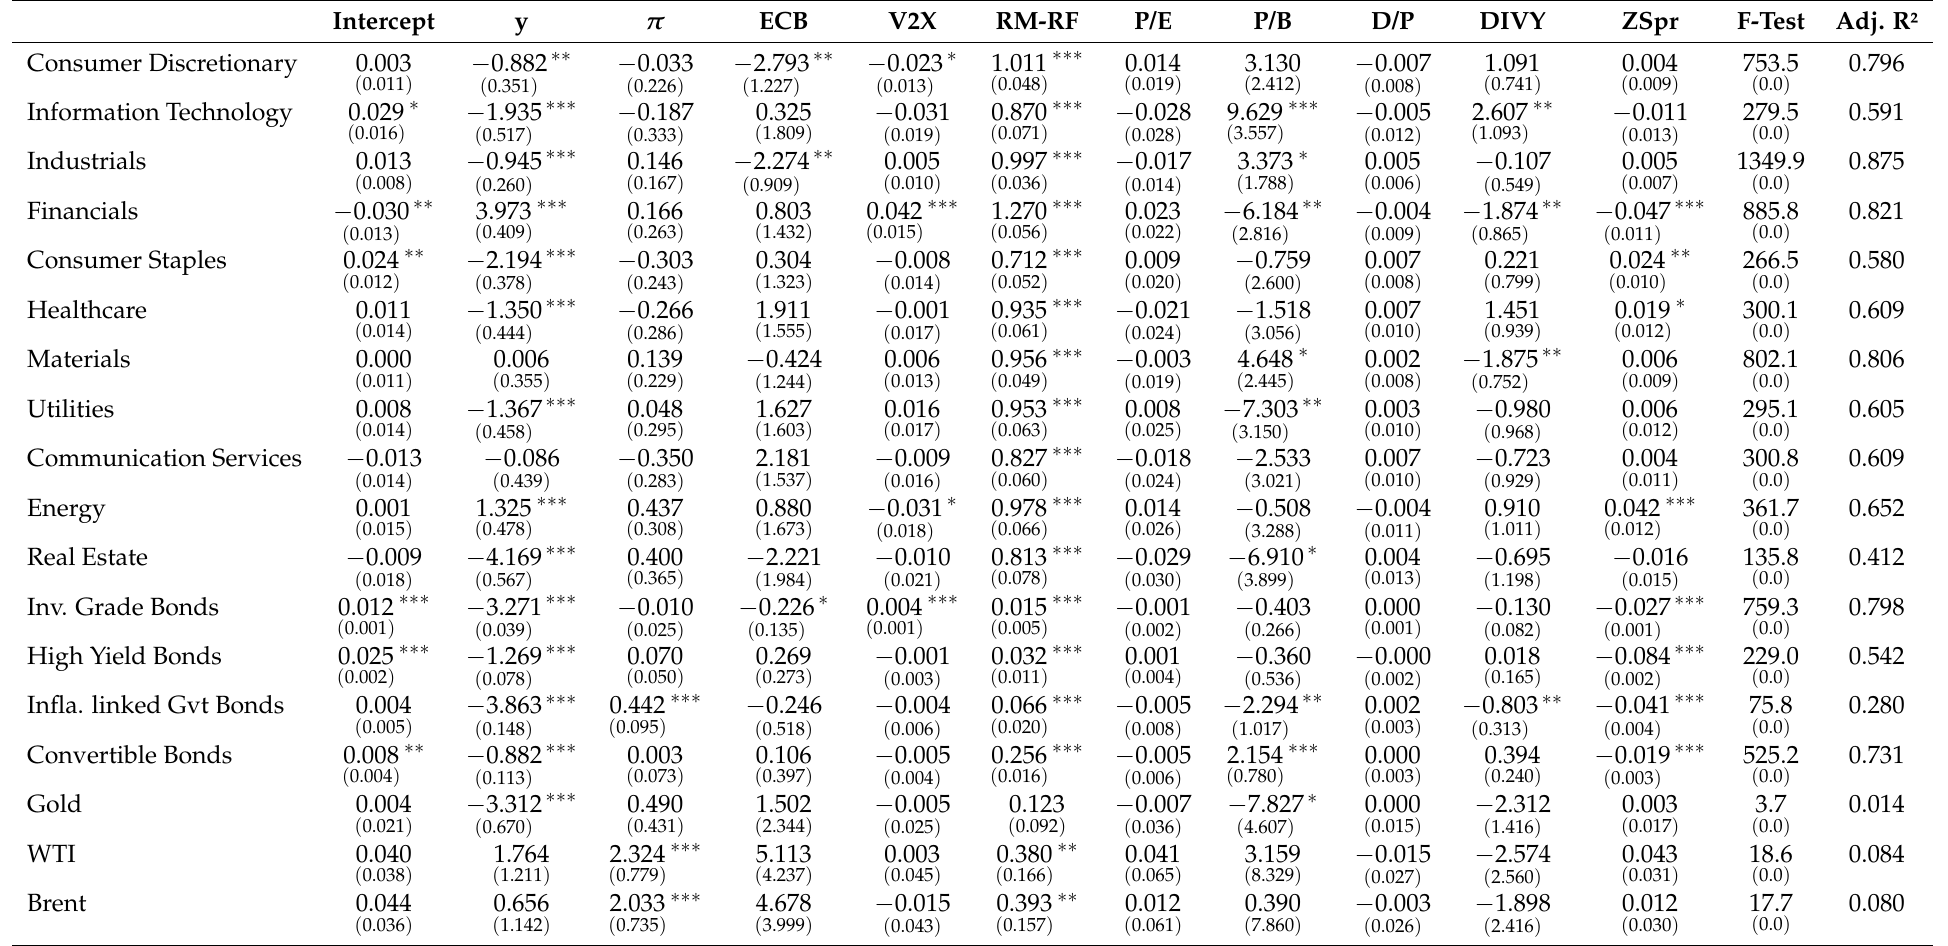
Table 6. Regression results for our panel under the low volatility regime of inflation expectations from 12 June 2009 to 02 November 2021. Error estimates are indicated in parentheses except for the F-Test, for which the p -value is in